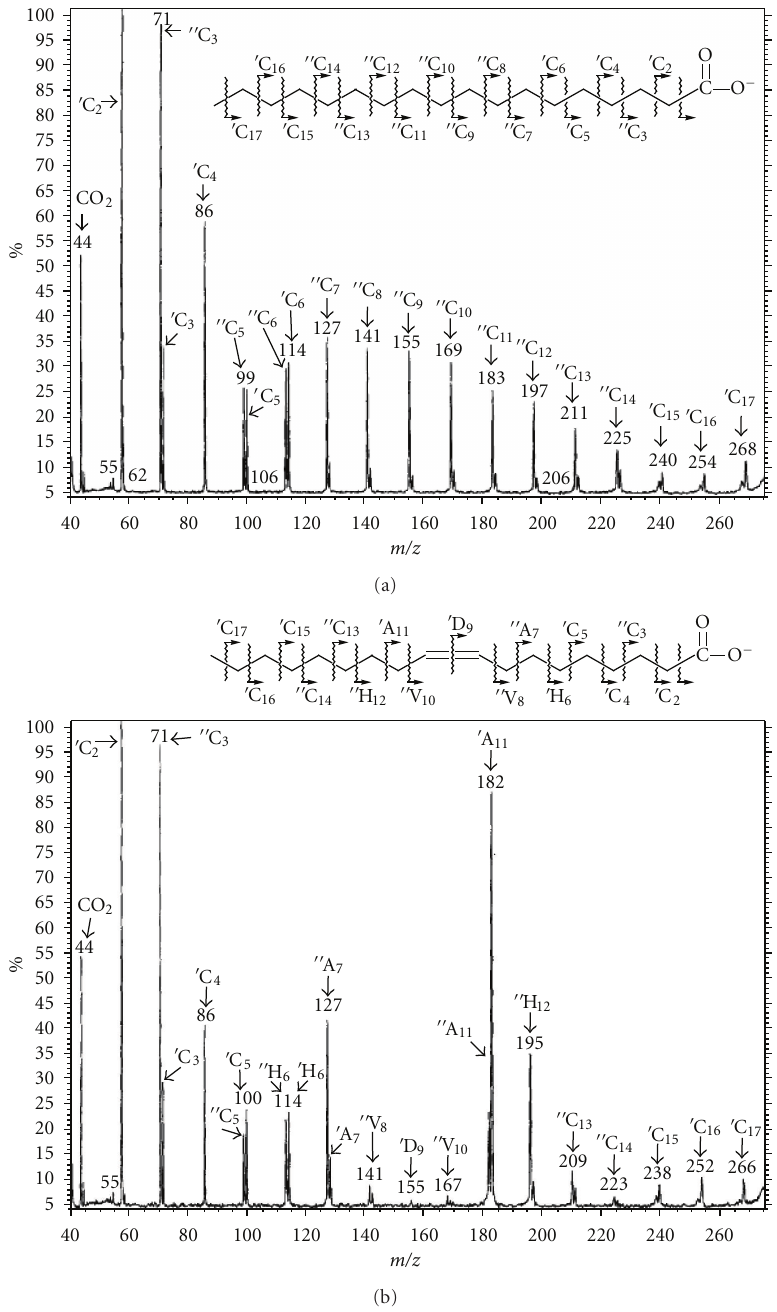
Figure 21: 400eV ( E lab ) CID spectra of stearic acid (a) and oleic acid (b) pseudomolecular anion. (Reprinted with permission from Rapid Communication in Mass Spectrometry [214], Copyright 1996, John Wiley and